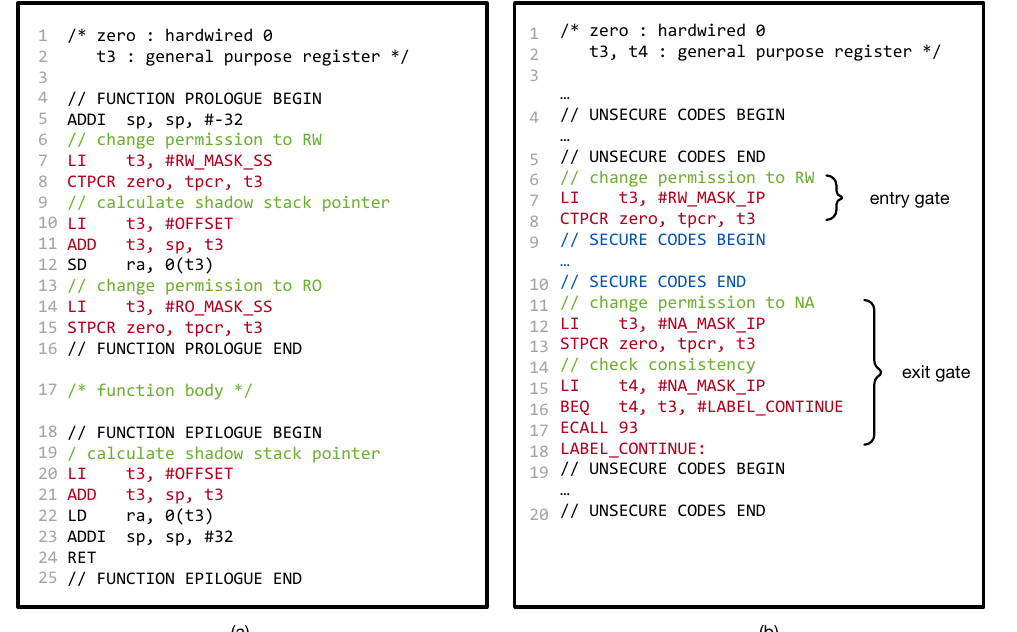
Figure 6. Shadow stack and In-process isolation in CoMeT : ( a ) pseudo code of shadow stack in CoMeT and ( b ) pseudo code of in-process isolation in CoMeT